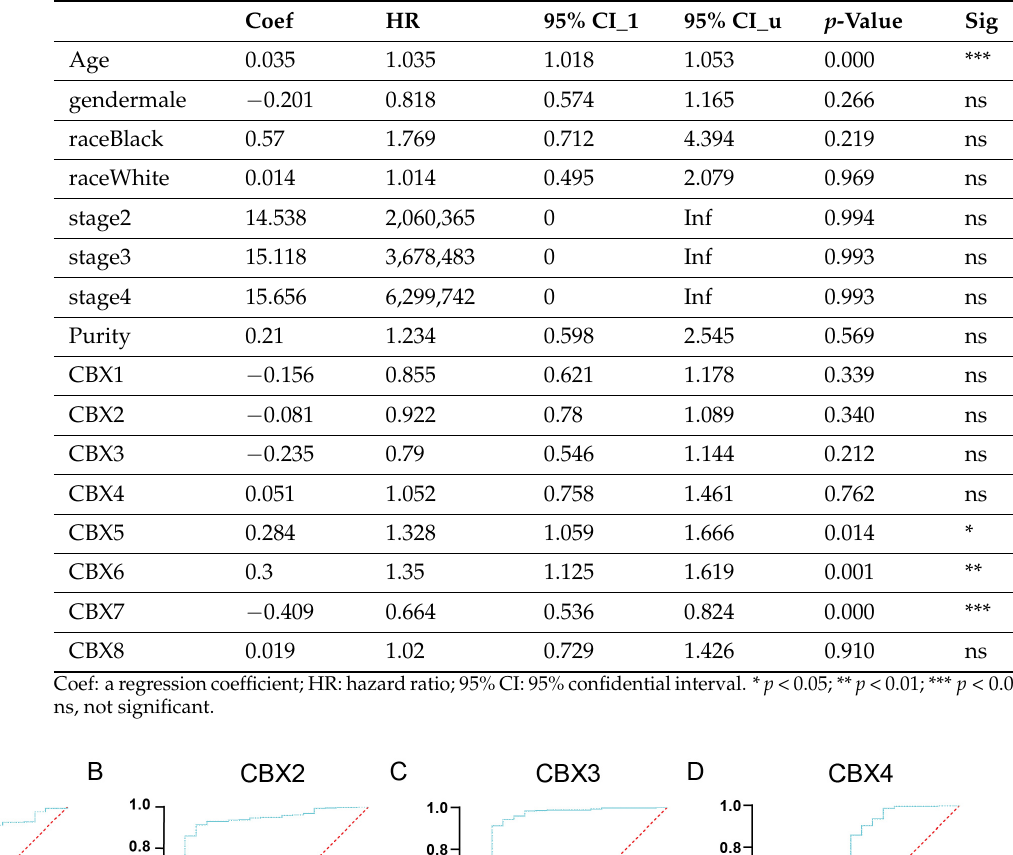
Table 1. The multivariable Cox regression model of CBXs and clinical factors analyzed by TIMER.